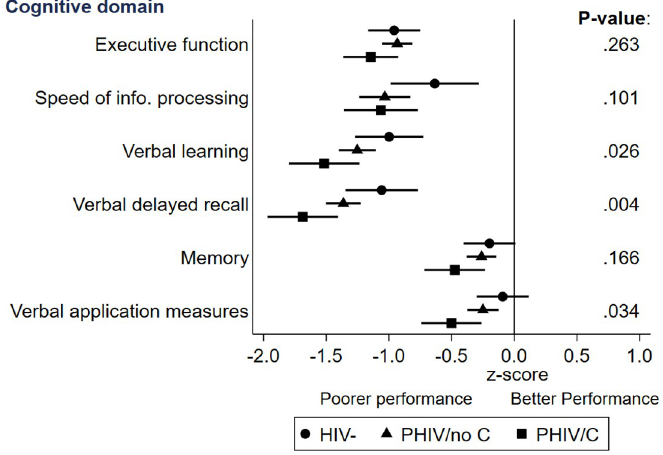
Fig 1. Cognitive performance by domain and HIV/CDC status. Data points are means with 95% confidence intervals. P-values compare the three groups (HIV, PHIV/no C, PHIV/C) using analysis of variance. Abbreviations: CDC, Centers for Disease Control and Prevention, HIV-, HIV negative; PHIV, perinatal HIV; PHIV/C, PHIV with a CDC C diagnosis; PHIV/no C, PHIV without a CDC C diagnosis.